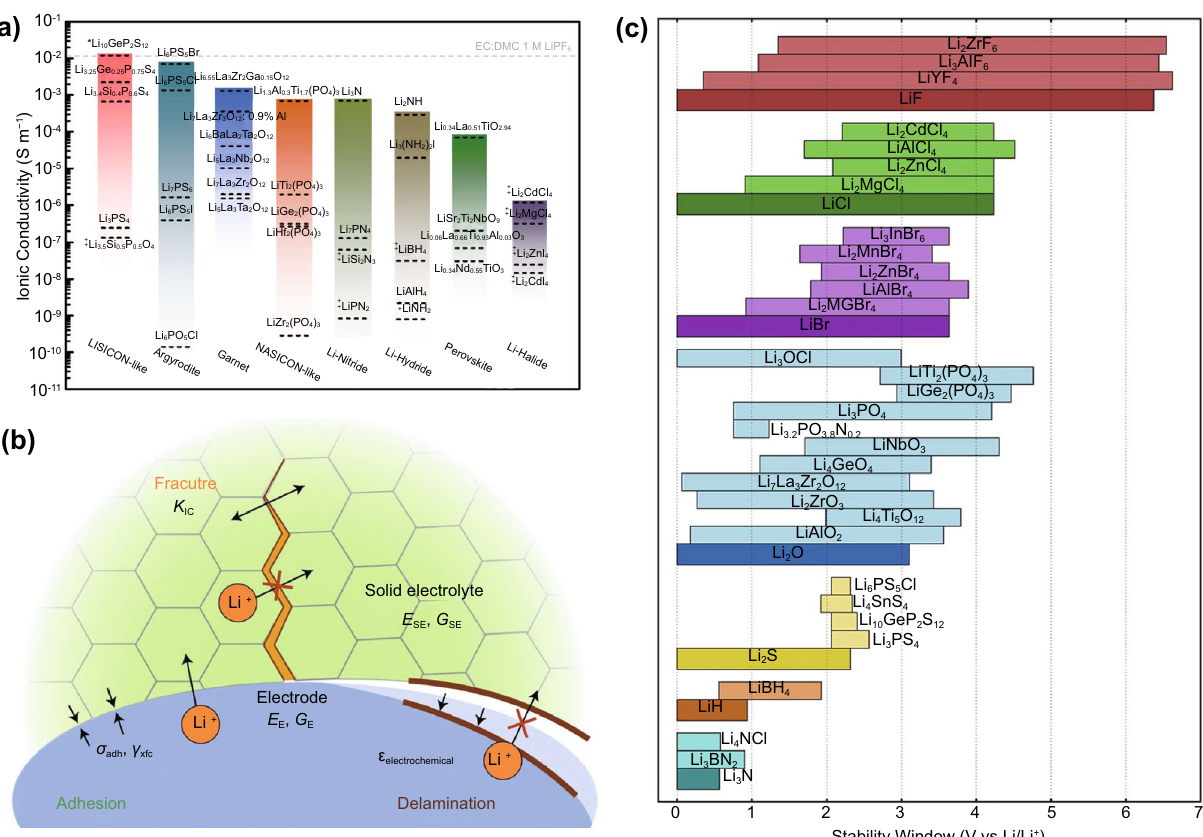
Fig. 16 a Lithium ionic conductivity of selected inorganic solid electrolytes and a comparison to a typical organic liquid electrolyte [227] . Cop- yright 2016, American Chemical Society. b Various inorganic solid electrolyte damage mechanisms that can occur as a result of cycling [232] . Copyright 2015, American Chemical Society. c The electrochemical stability window of some inorganic solid state lithium-ion conductors grouped by the anion type, along with the typically more stable but non-conducting binary compounds [233] . Copyright 2019, Springer